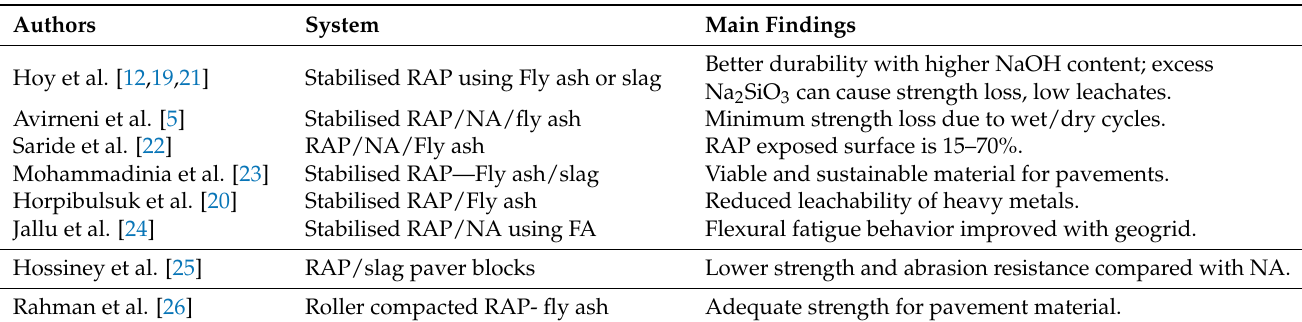
Table 1. Main studies on RAP and